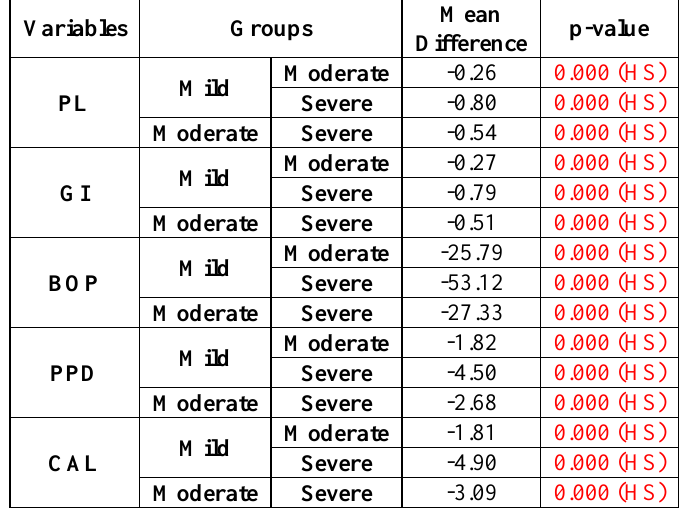
Table 3: Inter-groups comparisons of mean value of PLI, GI, BOP, PPD and CAL parameter